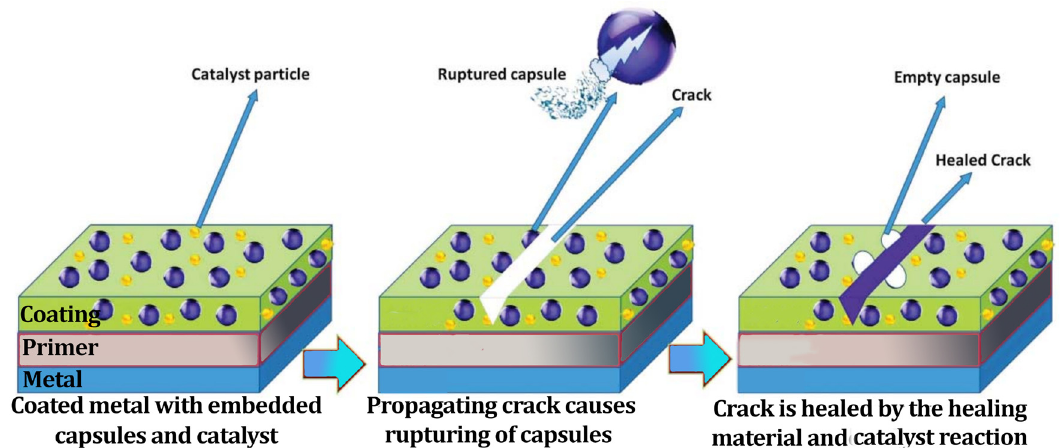
Figure 15: Schematic representation of crack healing by micro - encapsulated self - healing agent with a catalyst embedded in a resin matrix [ 104 ]